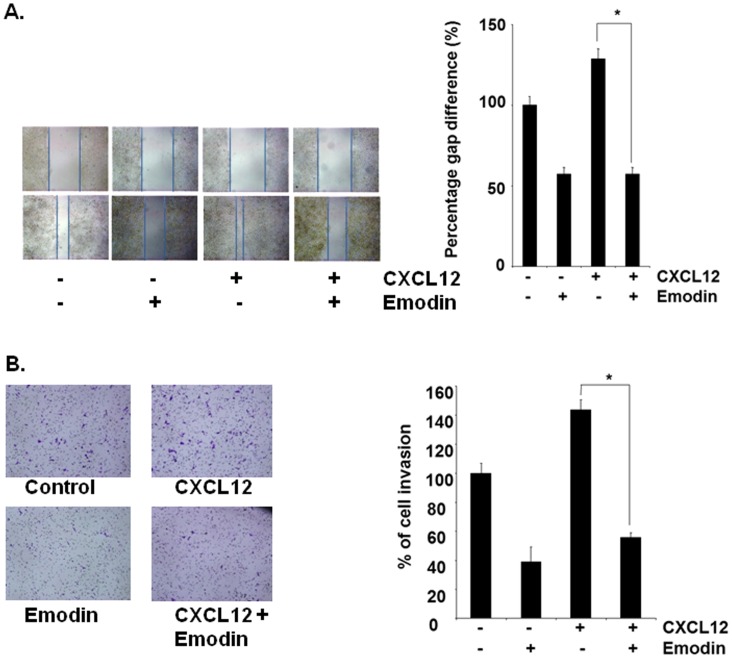
Emodin suppresses migration and invasion of Hep3B cells.A, Wound-healing assay for evaluating the inhibitory effect of emodin on cell migration. Confluent monolayers of Hep3B cells were scarred, and repair was monitored microscopically after 12 h of pre-treatment with emodin (50 µM) before being exposed to 100 ng/mL CXCL12 for 24 h. Width of wound was measured at time zero and 24 h of incubation with and without emodin in the absence or presence of CXCL12. The representative photographs of two independent experiments showed the same area at time zero and after 24 h of incubation. B, Hep3B (2×105 cells) were seeded in the top-chamber of the Matrigel. After pre-incubation with or without emodin (50 µM) for 12 h, transwell chambers were then placed into the wells of a 24-well plate, in which we had added either the basal medium only or basal medium containing 100 ng/mL CXCL12 for 24 h. After incubation, the chambers were assessed for cell invasion as described in Materials and Methods. Columns represent percentage of invaded cells; bars, SE. * indicates p value <0.05. Representative results of two independent experiments are shown.